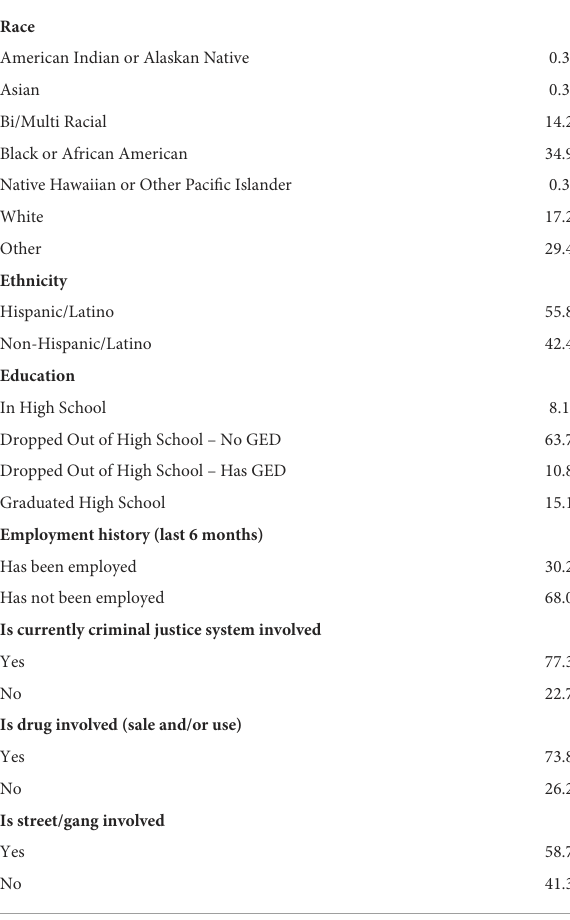
TABLE 1 Participant demographics at program intake ( N =